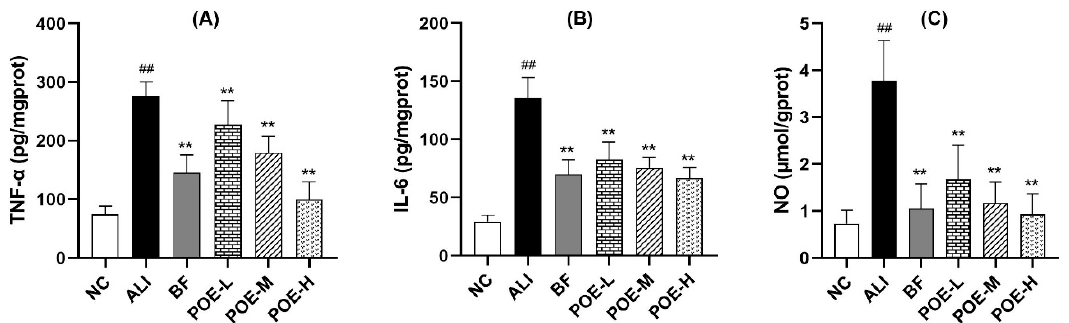
Figure 3. Effects of POE on inflammatory cytokine and mediators in alcoholic liver injury rats. ( A ) TNF- α , ( B ) IL-6, ( C ) NO. Values are presented as Mean ± SEM, n = 10. ## p < 0.01 compared with NC group. ** p < 0.01 compared with ALI group.